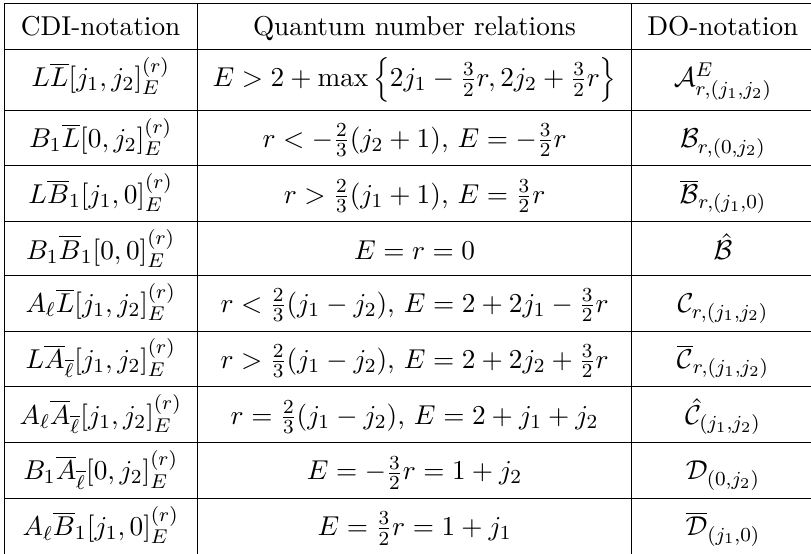
Table 14. Unitary representations of the su (2 , 2 | 1) superconformal algebra. In the above we have , ‘ = 2 if j = 0 , ‘ = 1 if j and ‘ = 2 if j = 0 . In the first column we list the 1 ‘ = 1 if j 1 ≥ 1 1 2 ≥ 2 2 2 notation of [40] and in third column we list the corresponding Dolan & Osborn style notation [39] which was also used in [48, 50, 87,